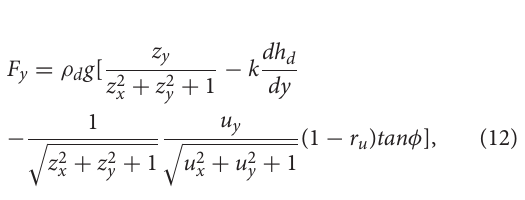
FIGURE 4 | Modeled surface albedo over the lower ablation zone of the Baltoro Glacier. The geomorphological conditions were estimated from an ASTER scene acquired on August 14th, 2004